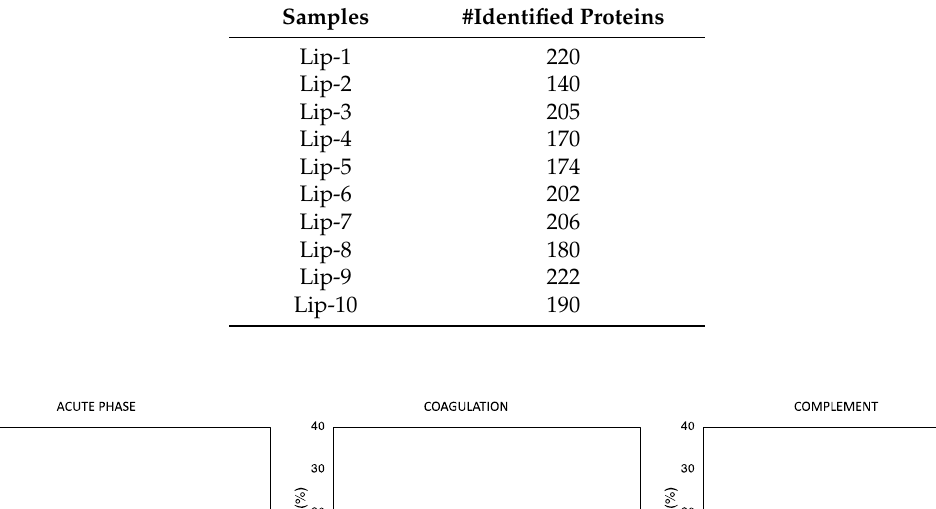
Table 4. Number of proteins adsorbed on liposomal formulations after 1-h incubation with HP.